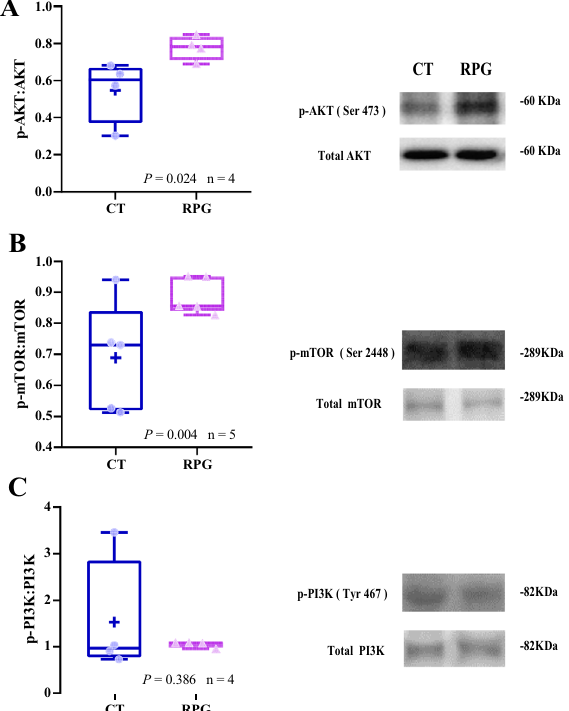
Figure 4. Box and whisker plots of the protein expression ratio of ( A ) p-AKT (Ser473): AKT, ( B ) p -mTOR (Ser2448): mTOR, and ( C ) p- PI3K (Tyr 467): PI3K proteins in ovarian tissue from postpartum dairy cows that show significant ( P < 0.01) between control diet and rumen-protected glucose diet. Figure 4 of the original blots/ gels is presented in Supplementary Fig.